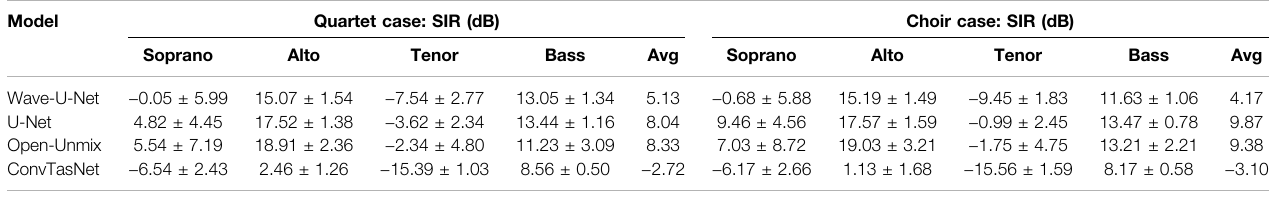
TABLE 5 | SIR results from modelname_CBDE evaluated on ECD songs (13 singers with all the singers in the mix), showing the training with data from the quartet case (left) and choir case (right). Model